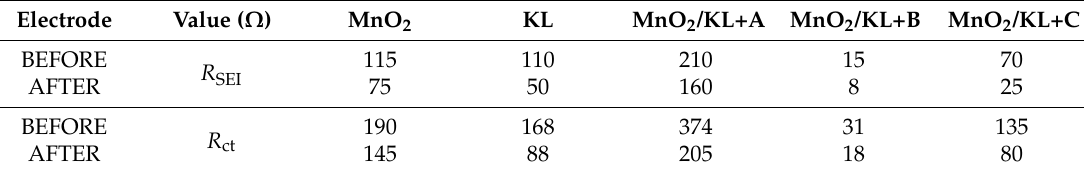
Table 6. The fitting value of the